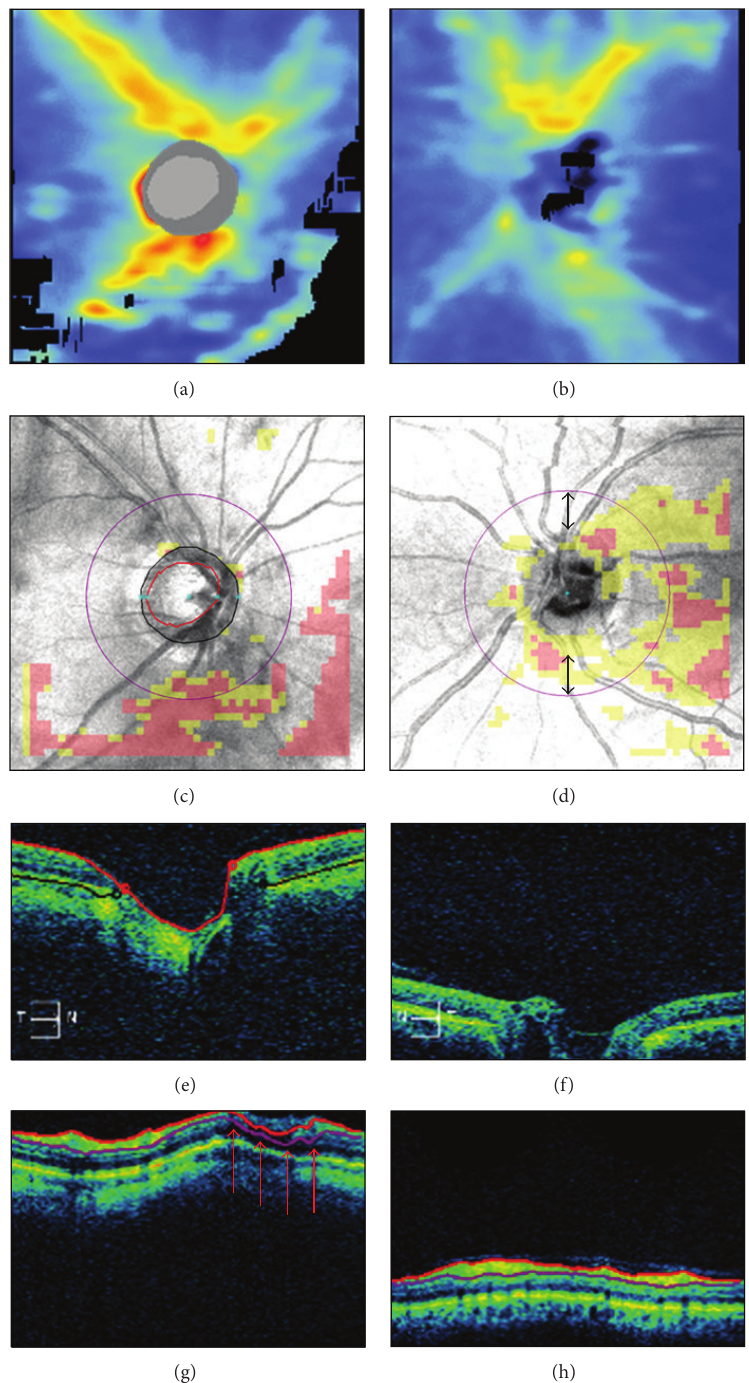
Figure 8: Incorrect axial alignment. Cirrus HD-OCT retinal nerve fiber layer (RNFL) thickness maps ((a)-(b)), RNFL deviation maps ((c)- (d)), horizontal ((e)-(f)), and circular ((g)-(h)) tomograms from two eyes. Left panels: partial truncation of the inner retinal layers; note the black areas of missing data on the RNFL thickness map (a), the corresponding clusters of “superpixels” on the RNFL deviation map (c), and the retinal nerve fiber layer segmentation artifact ((g) arrows). Right panels: partial truncation of the optic disc cup (f); note the algorithm failure to detect the optic disc (see (b), (d), and (f) and compare with the corresponding left panels). Thus, the scan circle was automatically placed in the center of the image, resulting in inferior scan circle displacement ((d) double